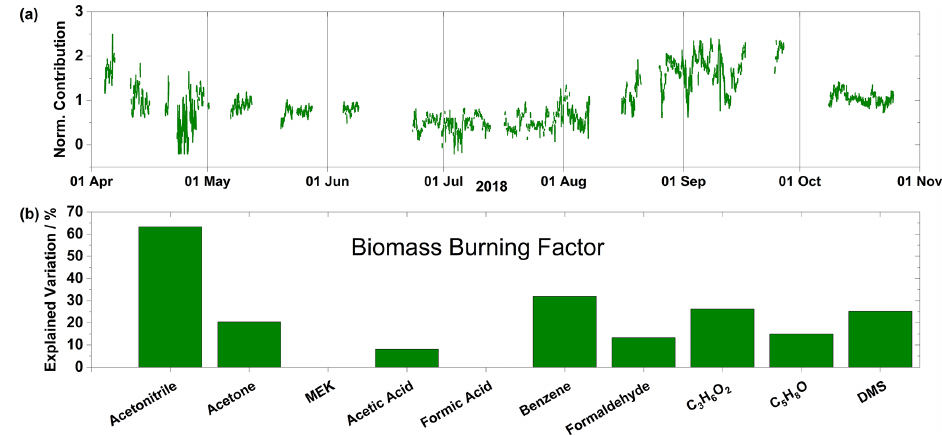
Figure 4. (a) Time series of normalized contributions and (b) species profile for the biomass burning factor. Factor contributions are normal- ized to give a mean contribution of